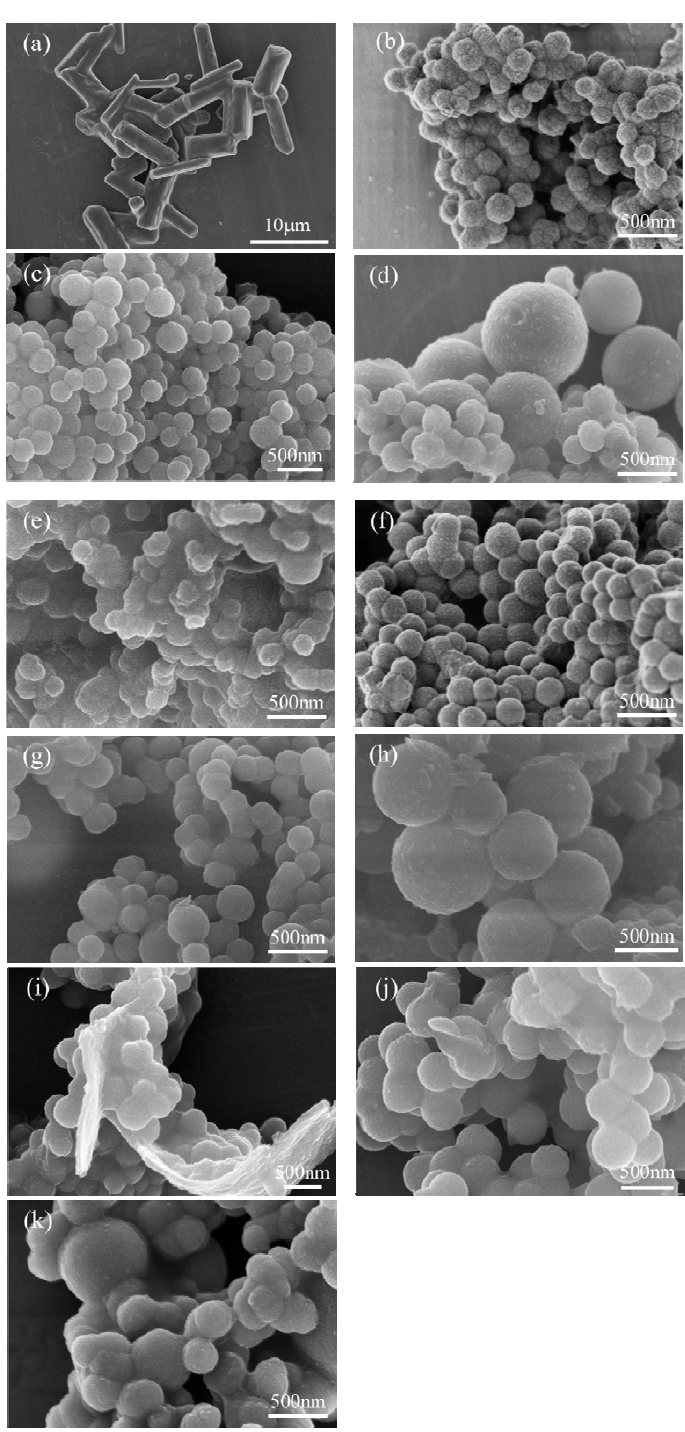
Figure 2. SEM micrographs of inositol and the nanocapsules: ( a ) IN; ( b ) NeIN1; ( c ) NeIN2; ( d ) NeIN3; ( e ) NeIN4; ( f ) NeIN5; ( g ) NeIN6; ( h ) NeIN7; ( i ) NeIN8; ( j ) NeIN9; ( k ) NeIN10.